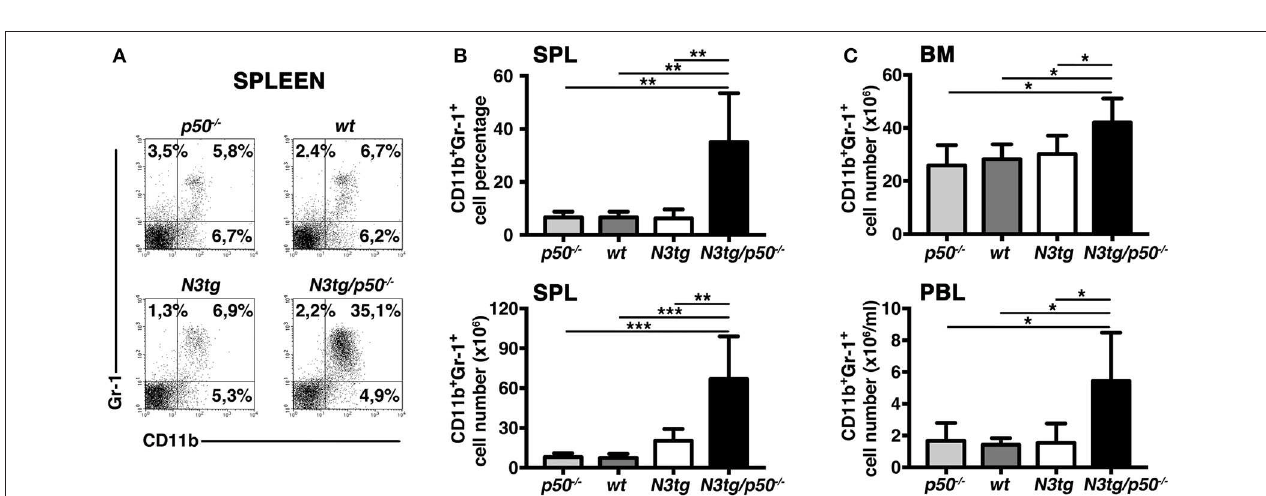
FIGURE 3 | Enlargement of CD11b + Gr-1 + subset in N3tg/p50 − / − mice. (A) Representative dot plots showing CD11b vs. Gr-1 distributions in the spleen of N3tg/p50 − / − , N3tg , p50 − / − , and wt mice at 8–9 weeks of age, as measured by FACS analysis. Numbers inside each cytogram represent the percentages of different cell subsets. (B) Percentages ( upper panel ) and absolute numbers ( lower panel ) of CD11b + Gr-1 + cells in the spleen from N3tg/p50 − / − , N3tg , p50 − / − , and wt mice, measured as in (A) . (C) absolute numbers of CD11b + Gr-1 + cells in the BM ( upper panel ) and peripheral blood lymphocytes (PBL) ( lower panel ) from N3tg/p50 − / − , N3tg , p50 − / − , and wt mice, measured as in (A) . In (B,C) data represent mean ± SD of five independent experiments ( n ≥ 5 mice per group). * P ≤ 0.05, ** P ≤ 0.01, and *** P ≤ 0.001 represent significant differences between the indicated